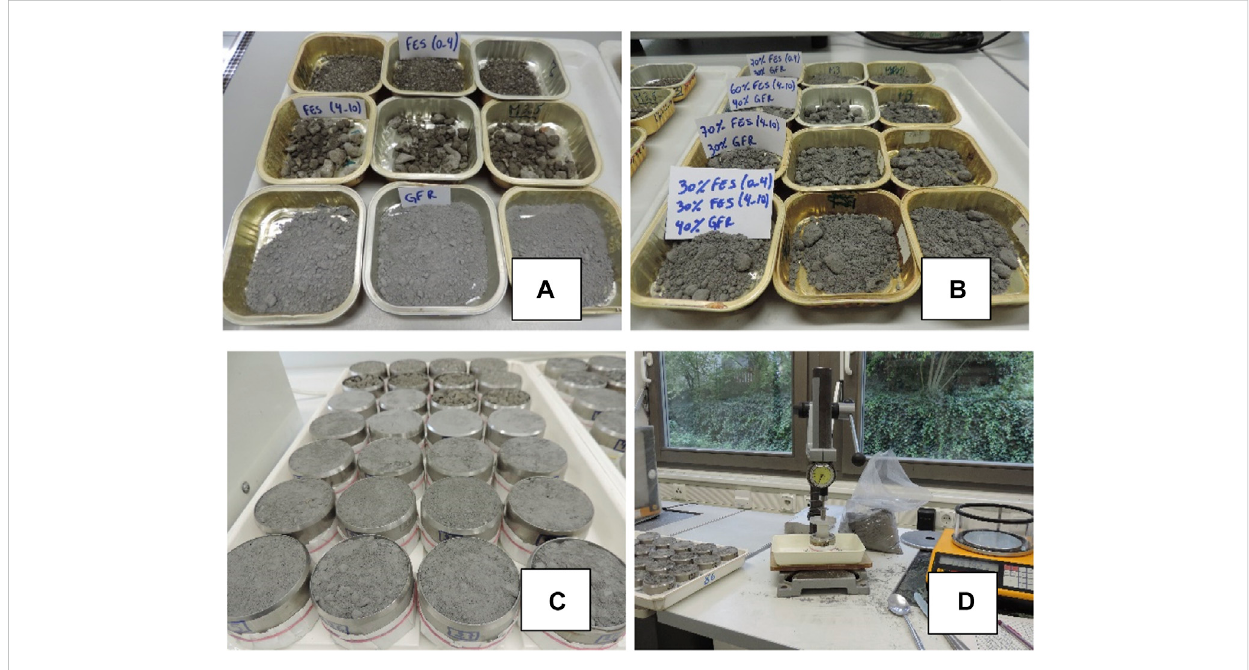
(Figure 3D), and dried at 105 C for 24 h. Five replicates were performed for each substrate, comprising 25 samples. The water content was determined using Equation